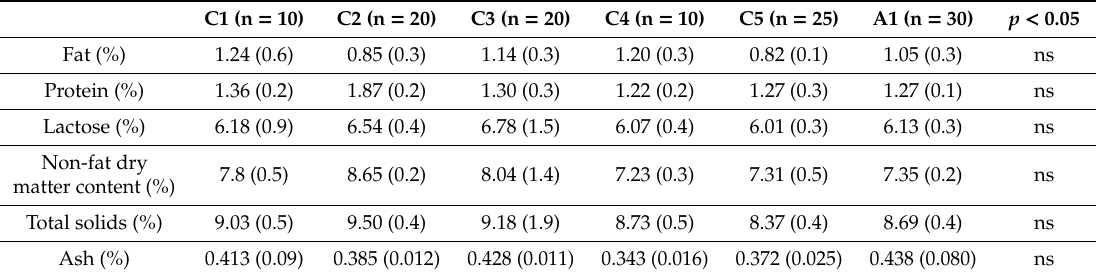
Table 2. Chemical composition of the donkey milk samples.